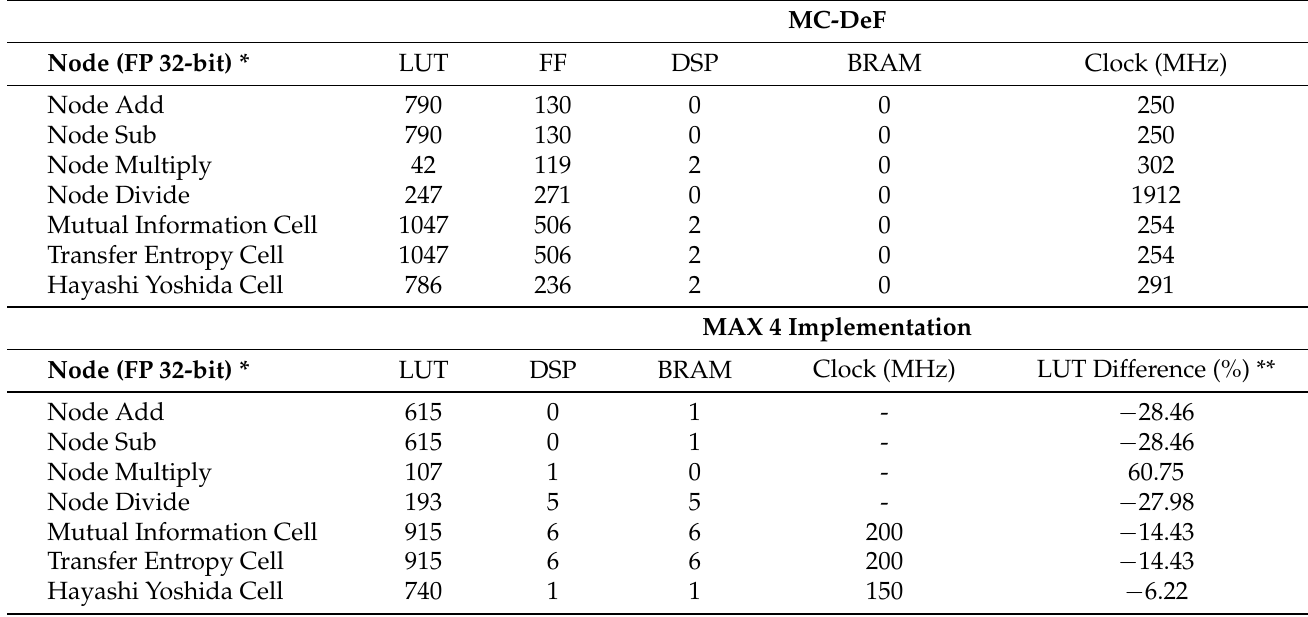
Table 7. Comparative results between MC-DeF VHDL implementation and the Maxeler MAX4. * Operations are 32-bit floating point (24-bit mantissa, 8 bit exp.) ** Positive numbers are favorable to the MC-DeF implementation.